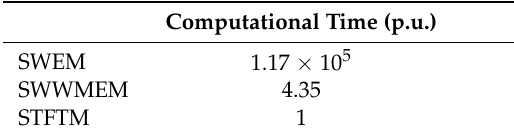
Table 5. Case study 3: computational times in per unit of computational time required by